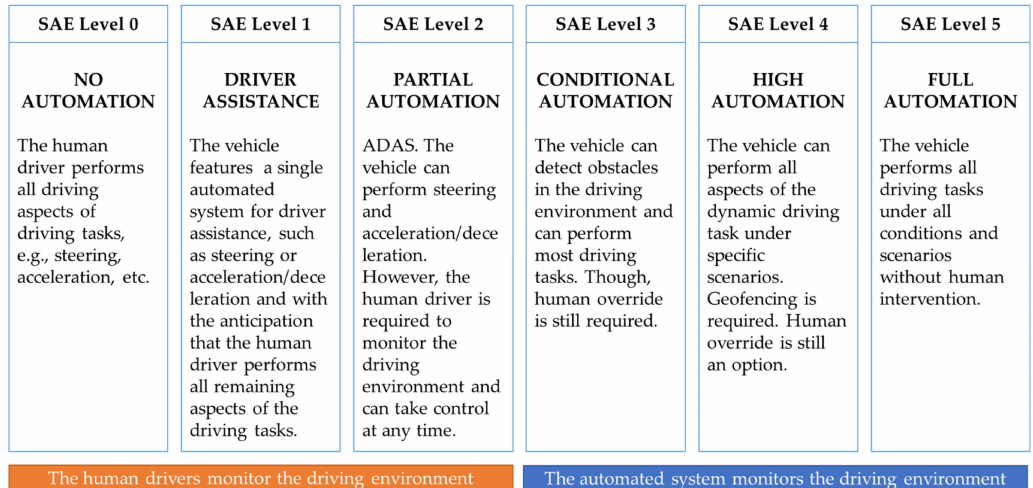
Figure 1. An overview of the six distinct levels of driving automation that were described in the Society of Automotive Engineers (SAE) J3016 standard. Readers interested in the comprehensive descriptions of each level are advised to refer to SAE International. Figure redrawn and modified based on depictions in